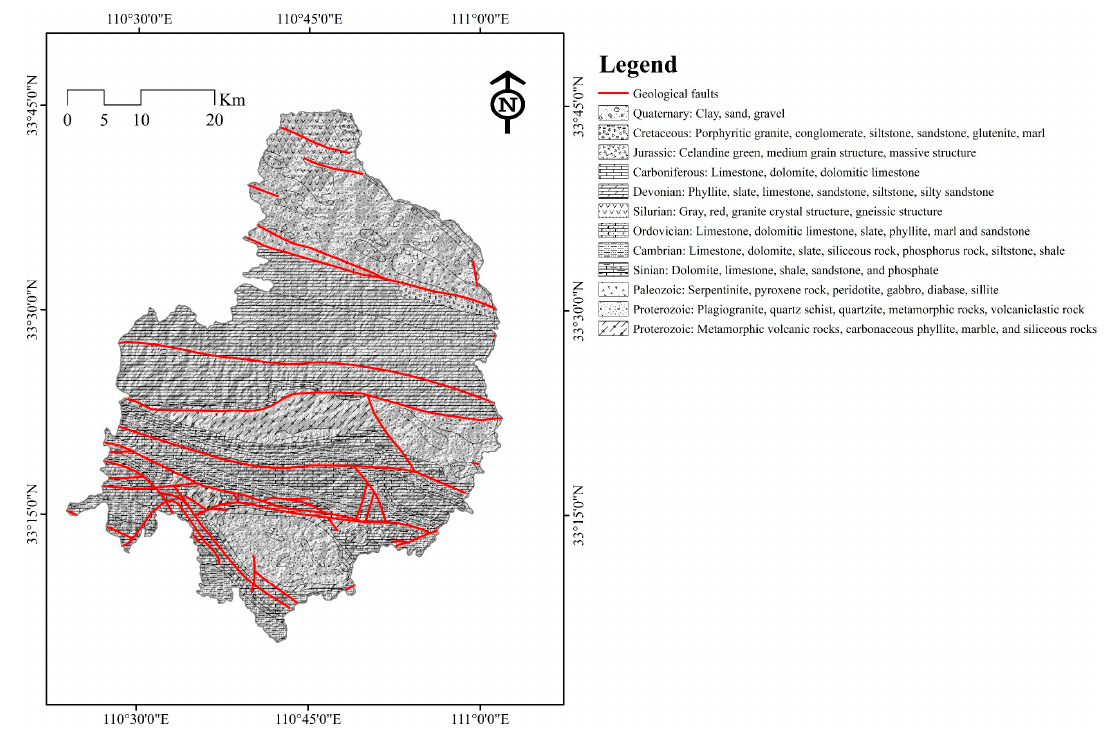
Table 1. Landslide conditioning factors.